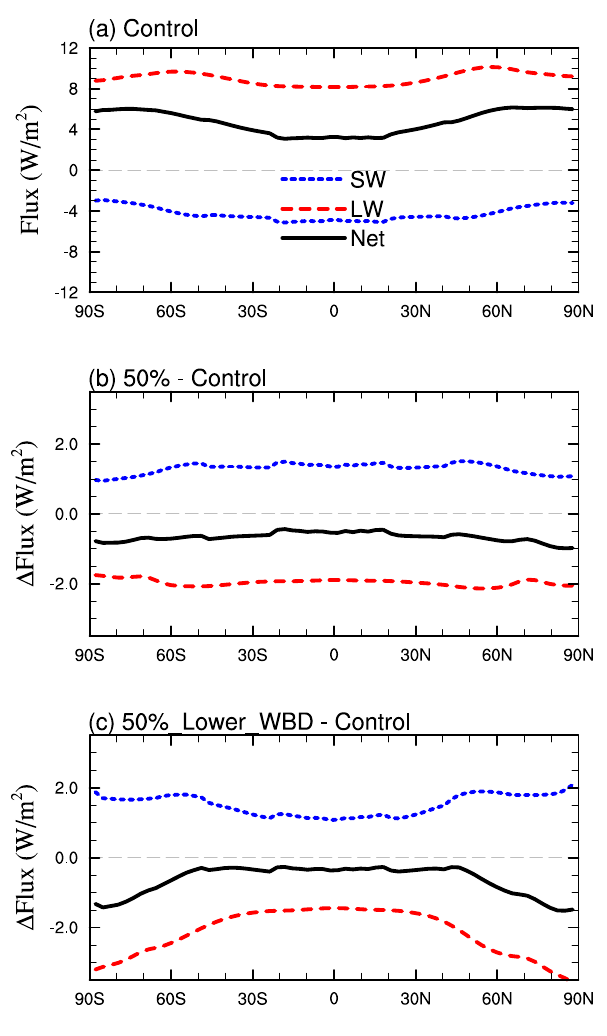
Fig. 4. Troposphere–surface radiative energy input under Snowball Earth conditions and 100ppmv of CO 2 . (a) the control experiment, (b) differences for the 50% scenario, and (c) differences for the 50% Lower WBD scenario. SW is shortwave absorption by the stratosphere multiplied by tropospheric co-albedo. The tropospheric co-albedo is 1.0 minus the albedo at the tropopause. That is, only a part of the shortwave absorption by the stratosphere is meaningful for the troposphere and surface, and the remainder would be scat- ted/reflected back to space by the troposphere and surface if there were no stratosphere (see Ramanathan and Dickinson, 1979). LW is downward longwave emission at the tropopause. Net is SW plus